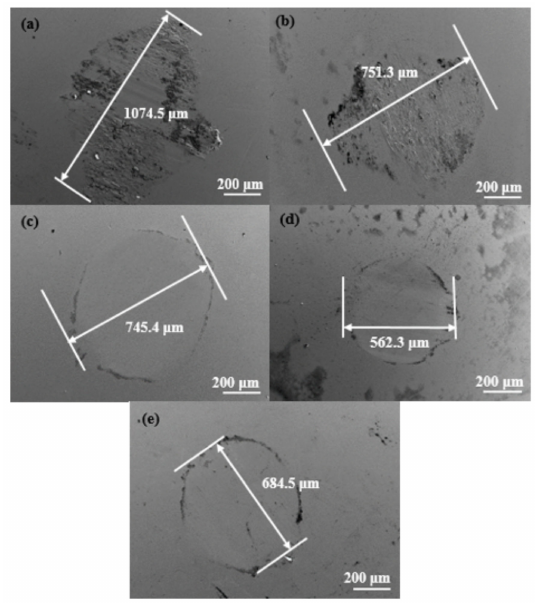
Figure 9. SEM images of morphology for wear scars on the dual ball sliding against ( a ) substrate and TiN coatings at R (N 2 ) of ( b ) 0.25, ( c ) 0.35 ( d ) 0.45 ( e ) 0.55 at load of 20 N under unlubricated